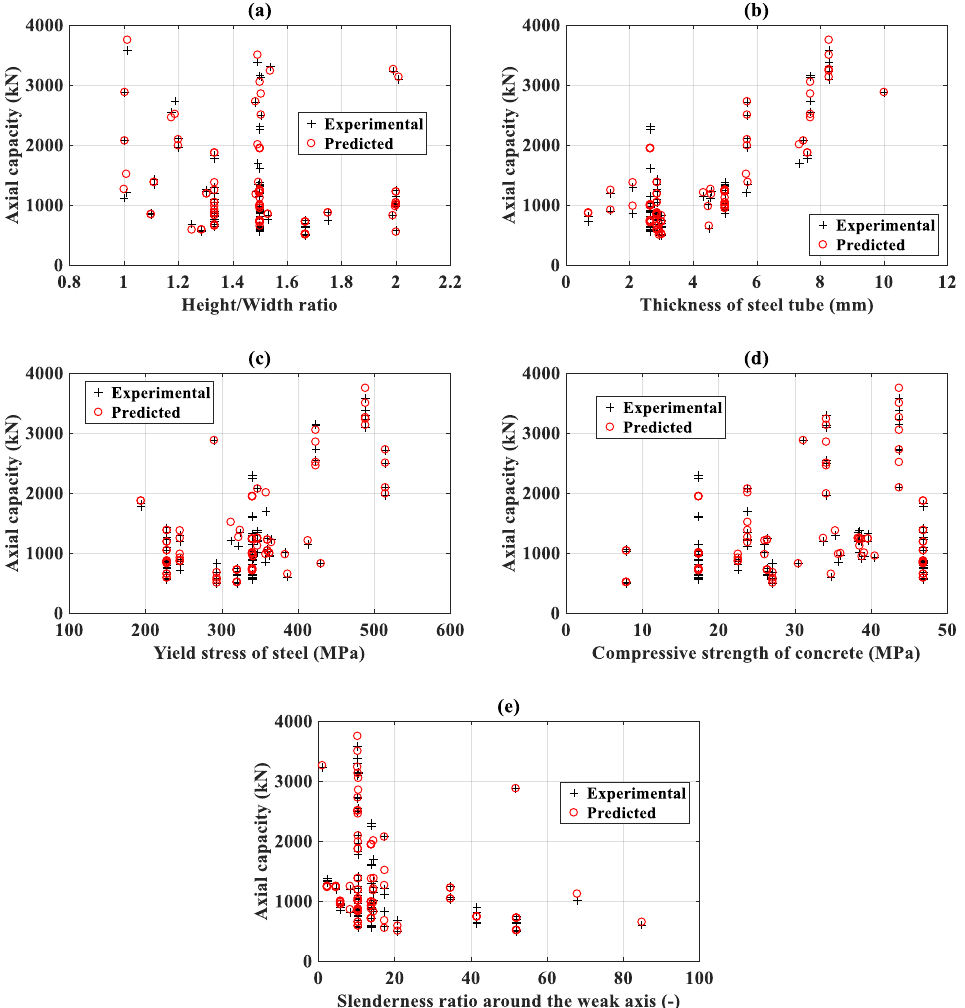
Figure 11. Evaluation of axial capacity in function of the ( a ) depth / width ratio, ( b ) thickness, ( c ) yield stress, ( d ) compressive strength, and ( e ) slenderness ratio.